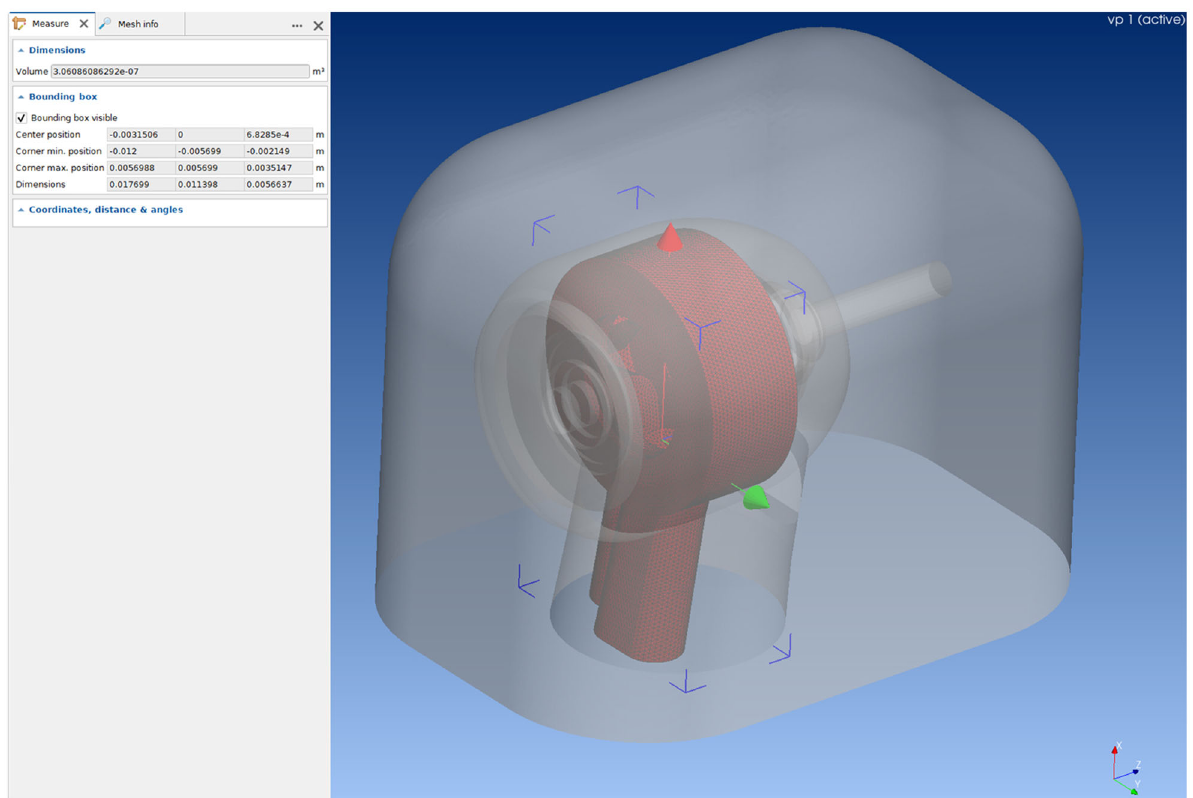
Fig. 2 The air layer mesh model within the handpiece and the surrounding exterior space. The air layer within the handpiece is depicted as brown color. The exterior space air layer is depicted as grey color. X, Y, and Z axis are shown as red, green, and blue arrows.